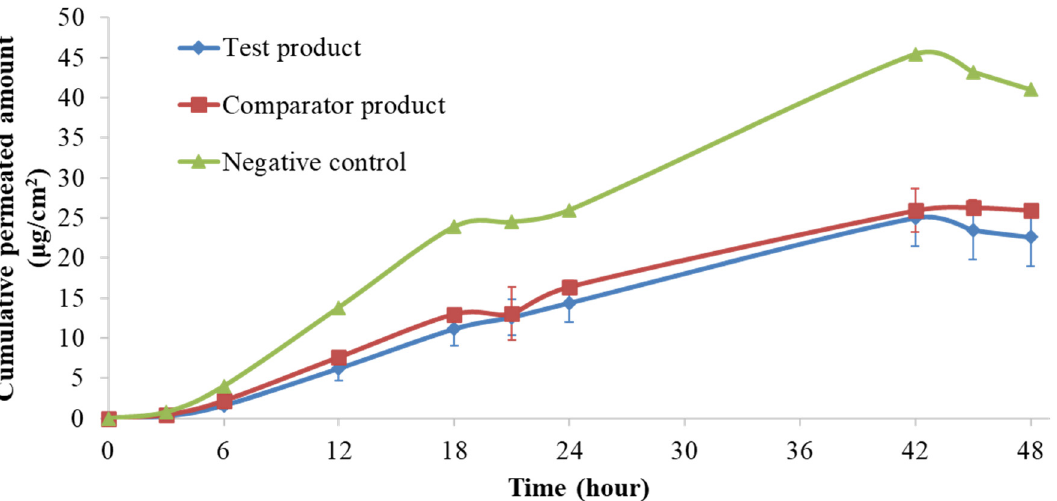
Figure 2. Cumulative permeated amount ( µ g/cm 2 ) per hour obtained in the pilot study ( n = 3 for the test and comparator products; n = 1 for the negative control; bars represent the mean).